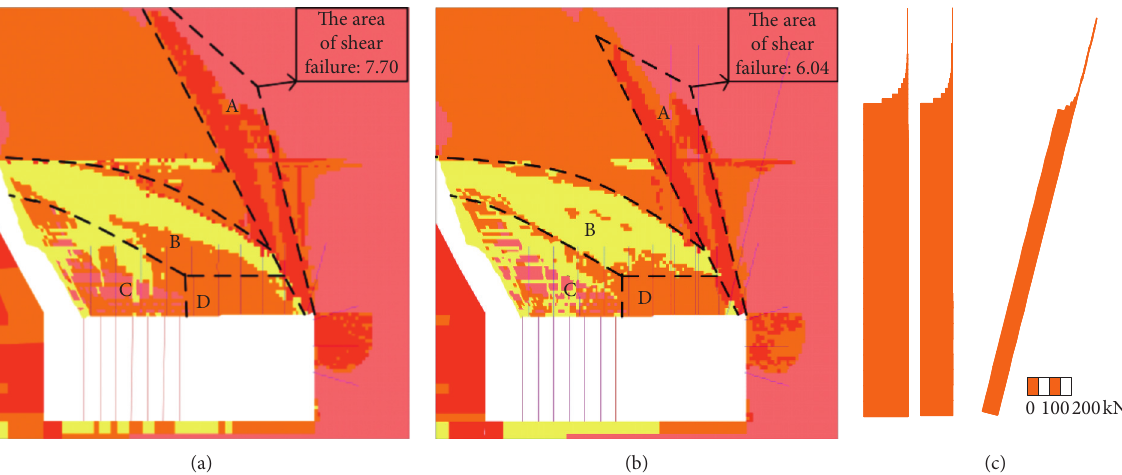
Figure 14: The shear failure around removal area with cables or not. (a) Support without cables. (b) Support with cables. (c) Axial force of cables.